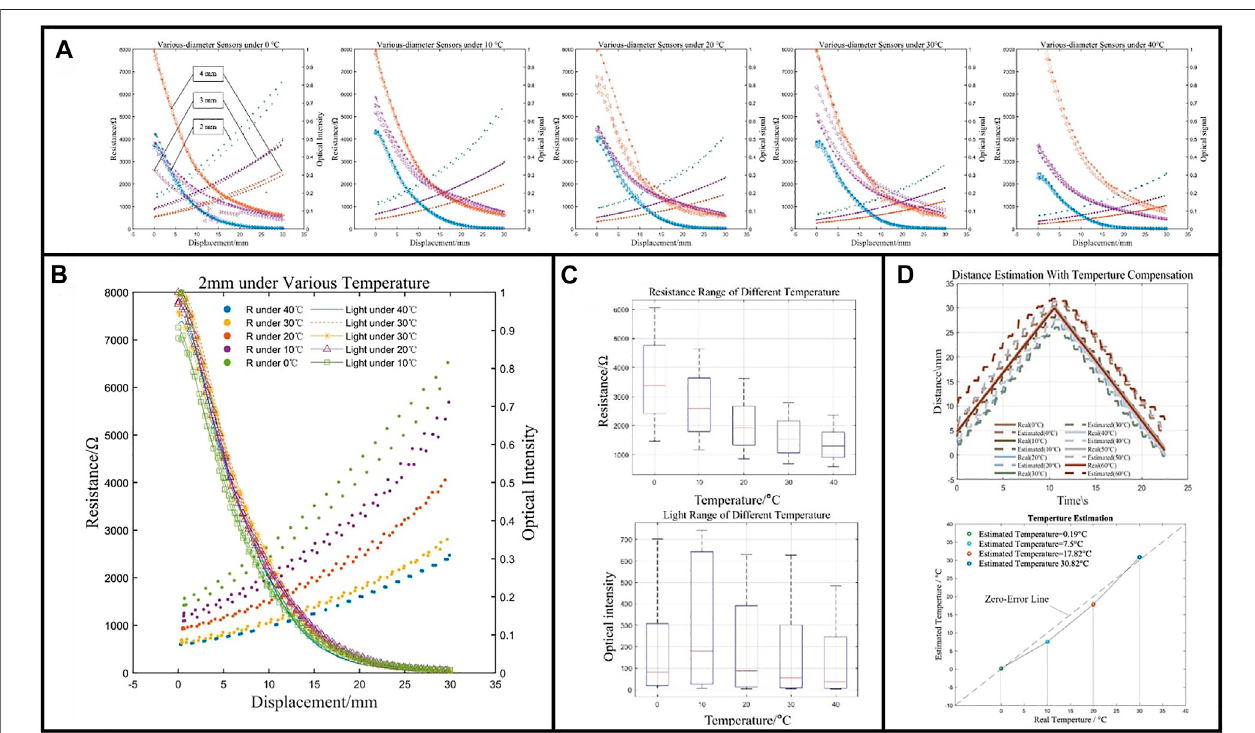
FIGURE10| Theperformanceofstretchingunderdifferentambienttemperatures. (A) SensingperformancesoftheMHSSensorwiththreedifferentdiameters. (B) Comparison ofperformance of2-mm-diameter sensor with thermal stimulus. (C) Resistance and optical intensity variation range of 2-mm-diameter sensor with thermal stimulus. (D) Displacement estimation and ambient temperature estimation.